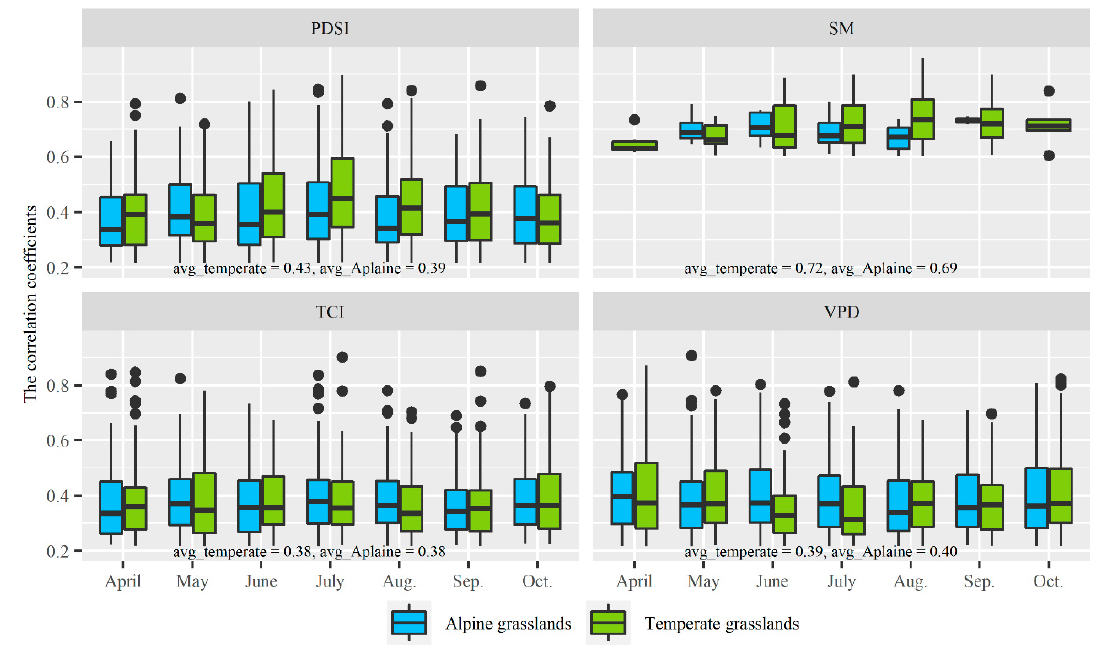
Figure 4. Correlation coefficients between SIF and ( a ) Palmer drought severity index PDSI, ( b ) soil moisture, ( c ) temperature condition index (TCI), and ( d ) vapor pressure deficit (VPD) for temperate grasslands and alpine grasslands. All the reported correlation coefficients are statistically significant ( p values < 0.05).